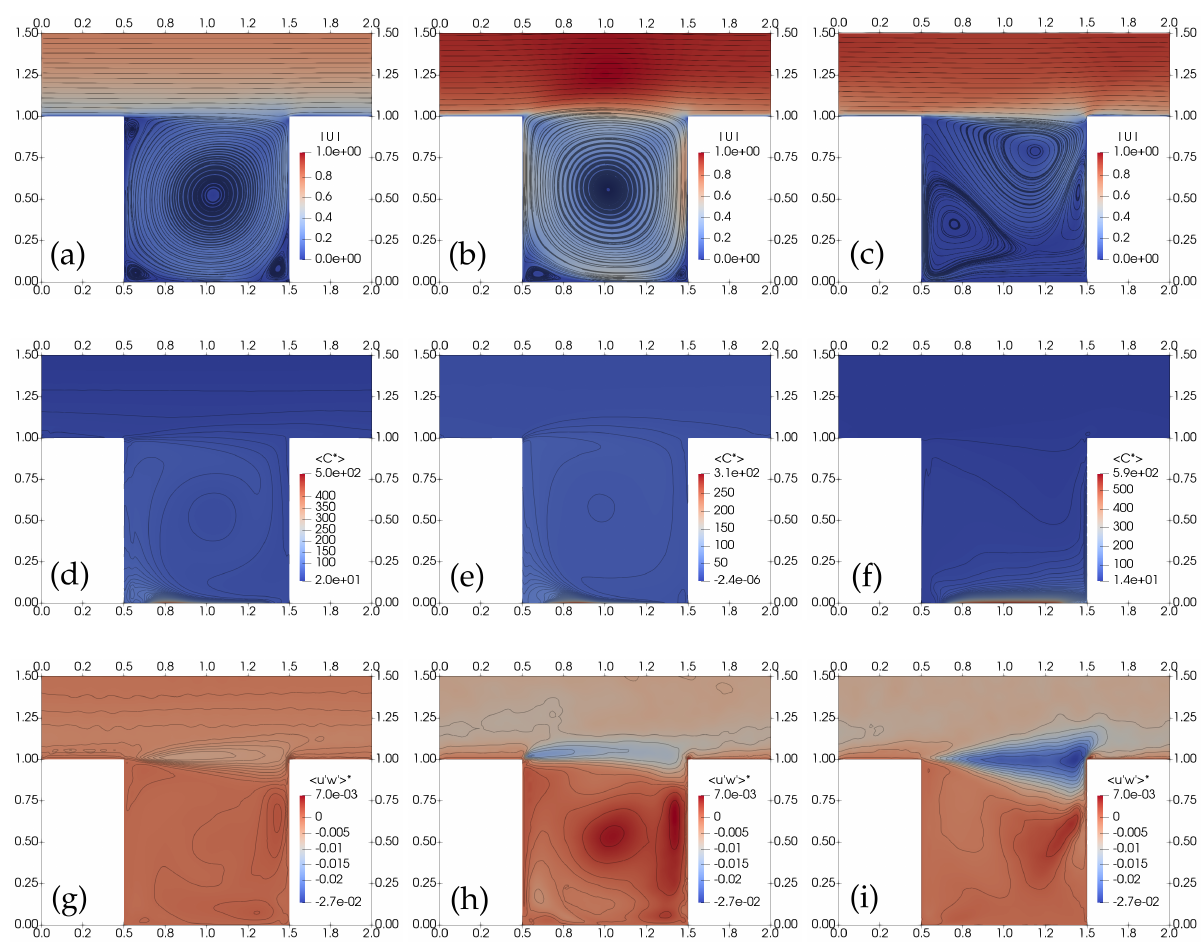
Figure 3. Velocity streamlines, concentration and turbulent kinematic momentum flux contour lines at a vertical plane perpendicular to the canyon ( y / H = 1) for the thee cases under consideration: first column, neutral case; second column, favourable case; third column, adverse case. The colour background shows the spatial distribution of quantities, which are made non-dimensional and averaged. ( a – c ) The non-dimensional mean velocity magnitude | U | = ( d – f ) The non-dimensional mean concentration C ∗ . ( g – i ) The non-dimensional mean turbulent kinematic momentum flux (cid:104) u (cid:48) w (cid:48) (cid:105)∗ = (cid:104) u (cid:48) w (cid:48) (cid:105) / U 2 0